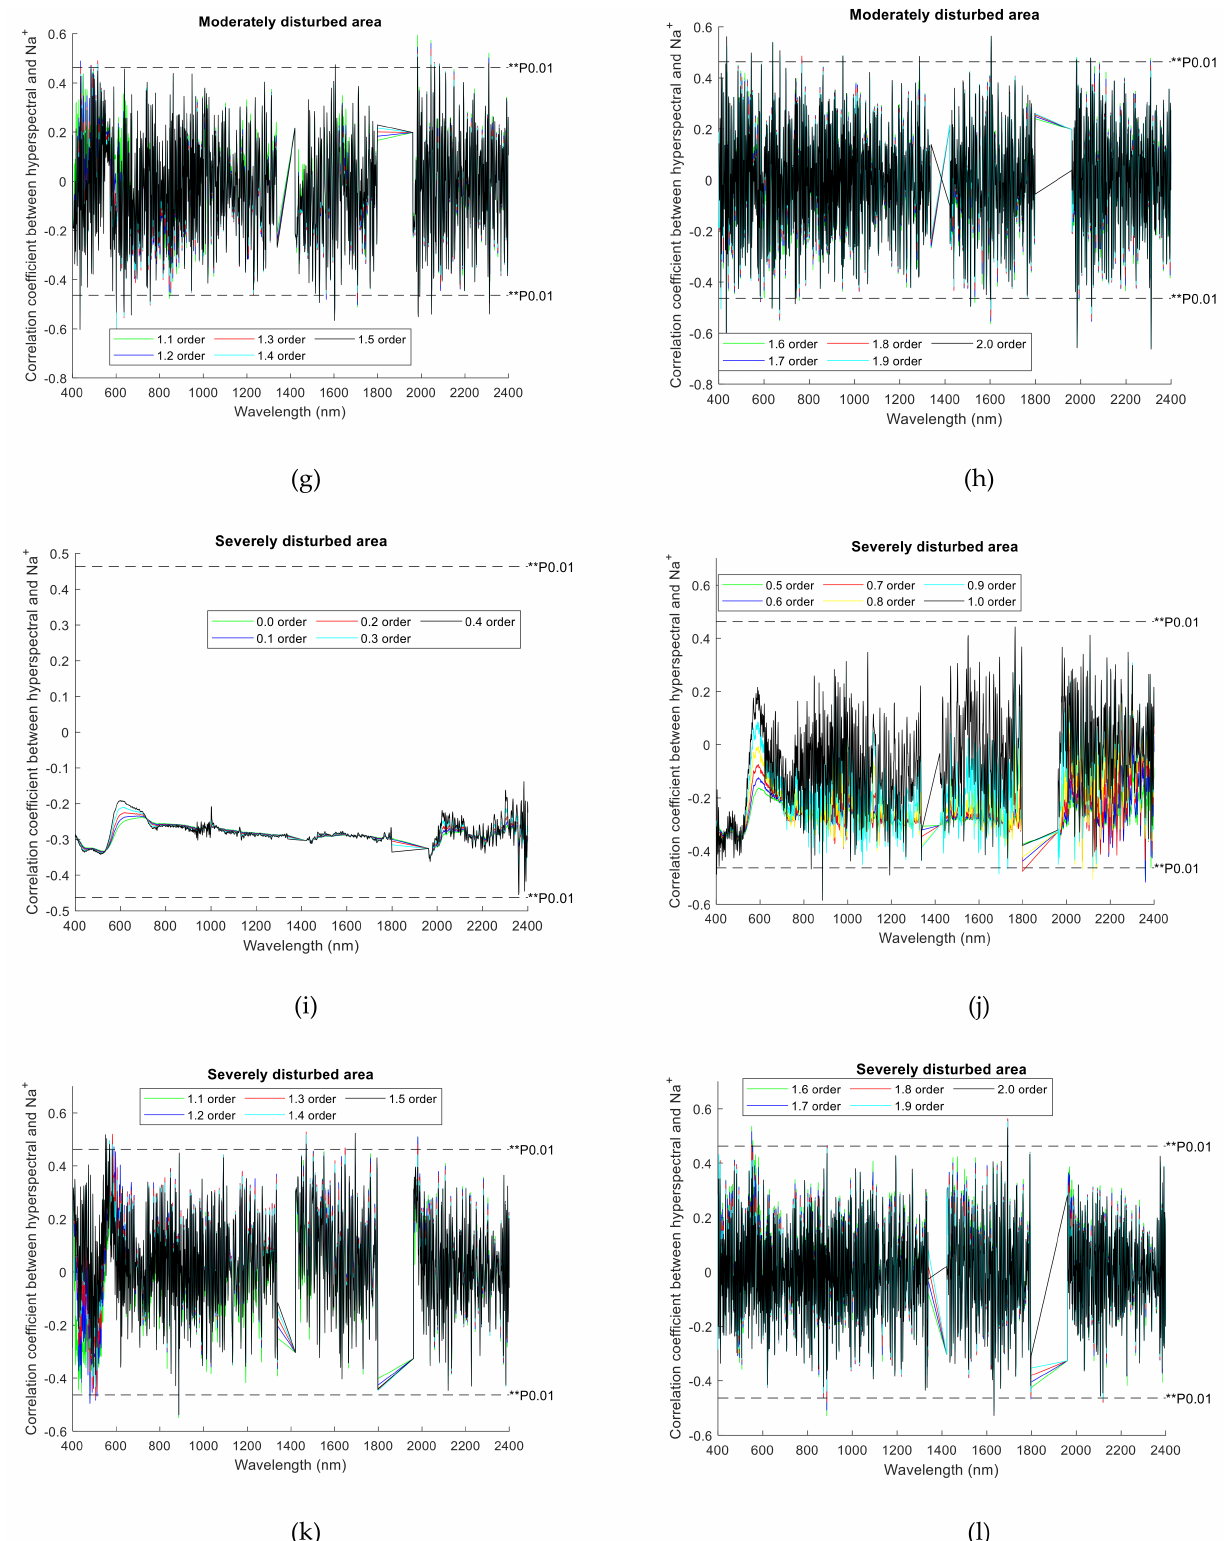
Figure 5. The correlation coefficient between soil hyperspectral and Na+ pretreated by FOD: ( a ) 0.0-order to 0.6-order in Area A; ( b ) 0.7-order to 1.0-order in Area A; ( c ) 1.1-order to 1.5-order in Area A; ( d ) 1.6-order to 2.0-order Area A. ( e ) 0.0-order to 0.4-order in Area B; ( f ) 0.5-order to 1.0-order in Area B; ( g ) 1.1-order to 1.5-order in Area B; ( h ) 1.6-order to 2.0-order in Area B. ( i ) 0.0-order to 0.4-order in Area C; ( j ) 0.5-order to 1.0-order in Area C; ( k ) 1.1-order to 1.5-order in Area C; ( l ) 1.6-order to 2.0-order in Area